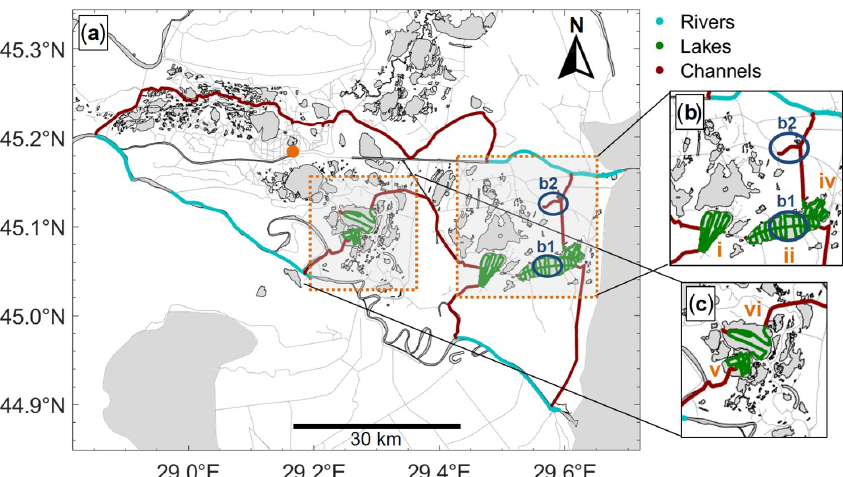
Figure 1. The Danube Delta, Romania, with the cruise tracks from the three seasonal campaigns split into rivers (blue), lakes (green) and channels (dark red). Systems of lake complexes in orange: Ro¸su–Puiu (b) and Gorgova–Uzlina (c) . Panels (b) and (c) show lakes Puiu ( b (i)), Ro¸su ( b (ii)), Ro¸sule¸t ( b (iv)), Uzlina ( c (v)) and Isac ( c (vi)). Blue circles indicate the sites of the two diel cycles at Lake Ro¸su ( b (b1)) and the hot spot channel ( b (b2)), both during the August campaign. The Gorgova meteorological station is located in the middle of the delta (orange dot). More in-depth labelling can be found in Sect. S1.3.